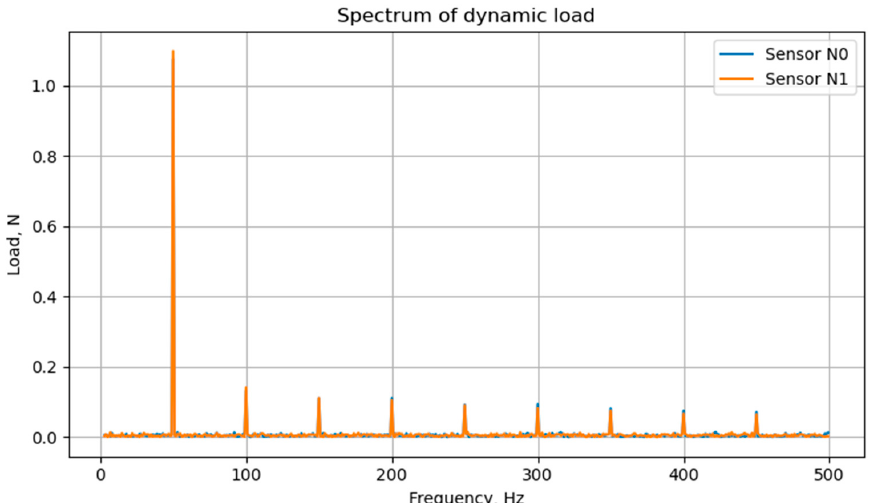
Figure 8. Spectrum of the simulated signal coming to two sensors.